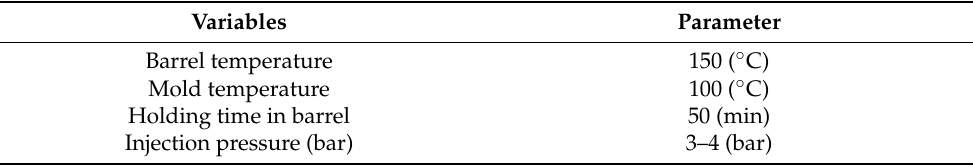
Table 1. Processing conditions of the injection molding technique used for the fabrication of the HDPE